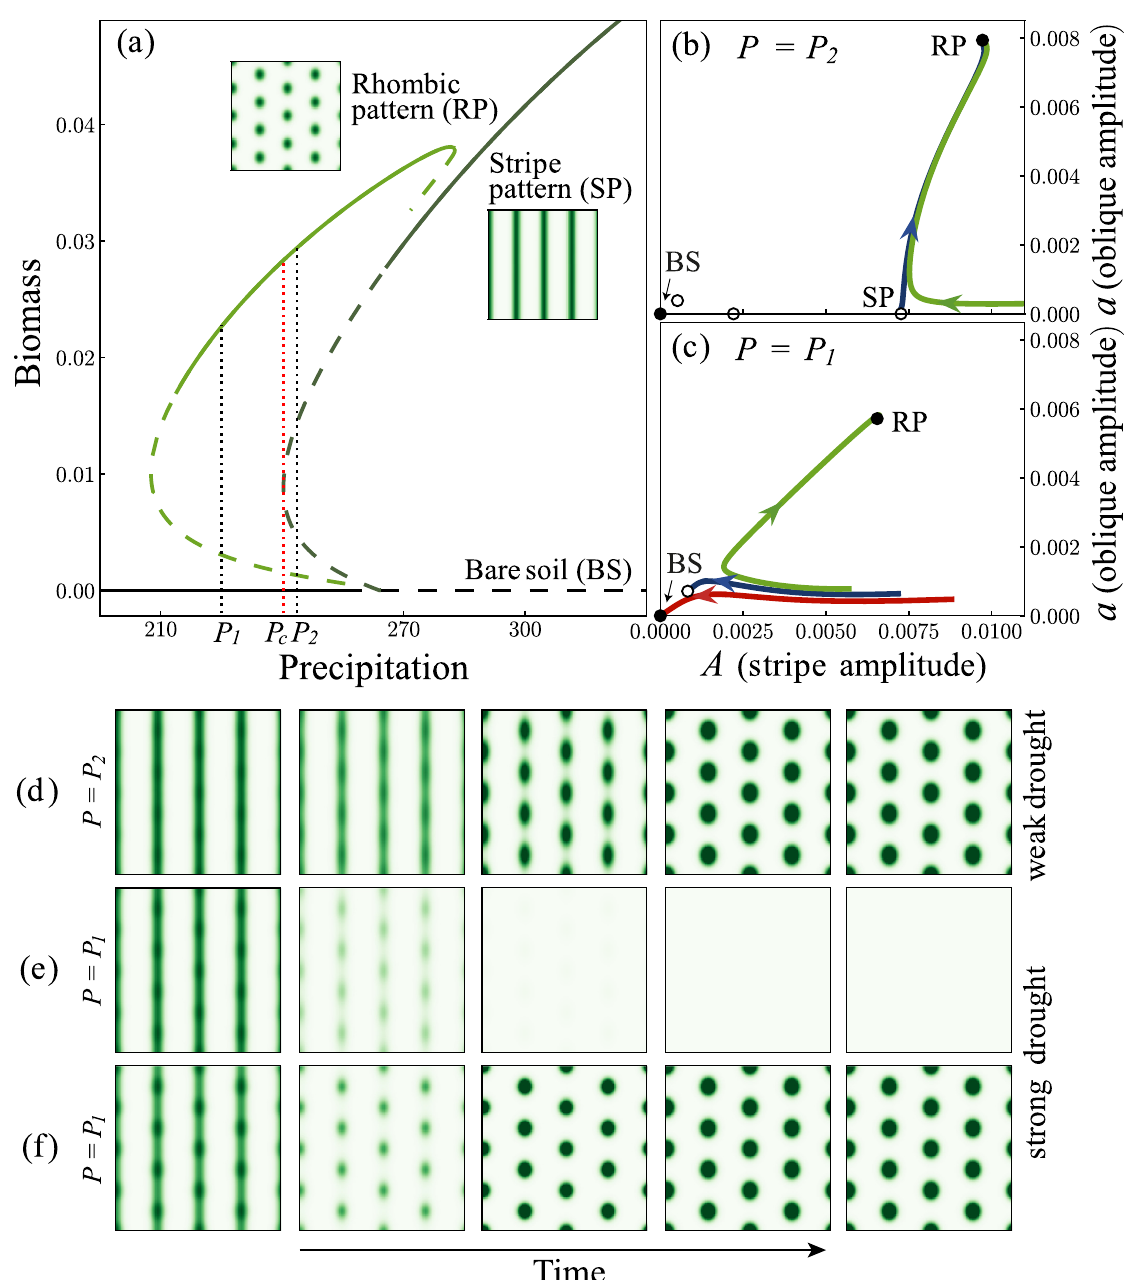
Fig 3. Vegetation rehabilitation using periodic ground modulations. (a) A partial bifurcation diagram obtained from Eq (3), showing bare soil state (black line, BS), a stripe pattern (dark green line, SP) and a rhombic pattern (light green line, RP). Solid (dashed) lines represent stable (unstable) states. The insets show examples of two-dimensional spatial biomass distributions of the two patterned states. The stripe pattern disappears in a saddle-node bifurcation at precipitation P c . (b,c) Phase space spanned by the self-organized (SO) variables A and a above the saddle-node bifurcation ( P = P 2 > P c ) and below it ( P = P 1 < P c ), respectively. Solid (open) circles represent stable (unstable) states. They correspond to the intersection points of the black vertical dotted lines in panel (a) with the various solution branches. The lines in blue represent stable and unstable manifolds. At P = P 2 , where the unstable stripe pattern still exist, phase trajectories that emanate from a nearly stripe-pattern state converge to the rhombic pattern (green line in panel b). In contrast, at P = P 1 , where the stripe- pattern state no longer exists, phase trajectories collapse to bare soil (red line in panel c). However adding small components of the oblique modes to an initial stripe pattern places the system above the stable manifold of the unstable rhombic pattern and results in convergence to the rhombic pattern (green line in panel c). (d-f) Snapshots of a 13 × 13 [m] domain, taken over time (left to right) showing response of ecosystem to a drought, corresponding to green line in panel b, and red and green lines in panel c, respectively.